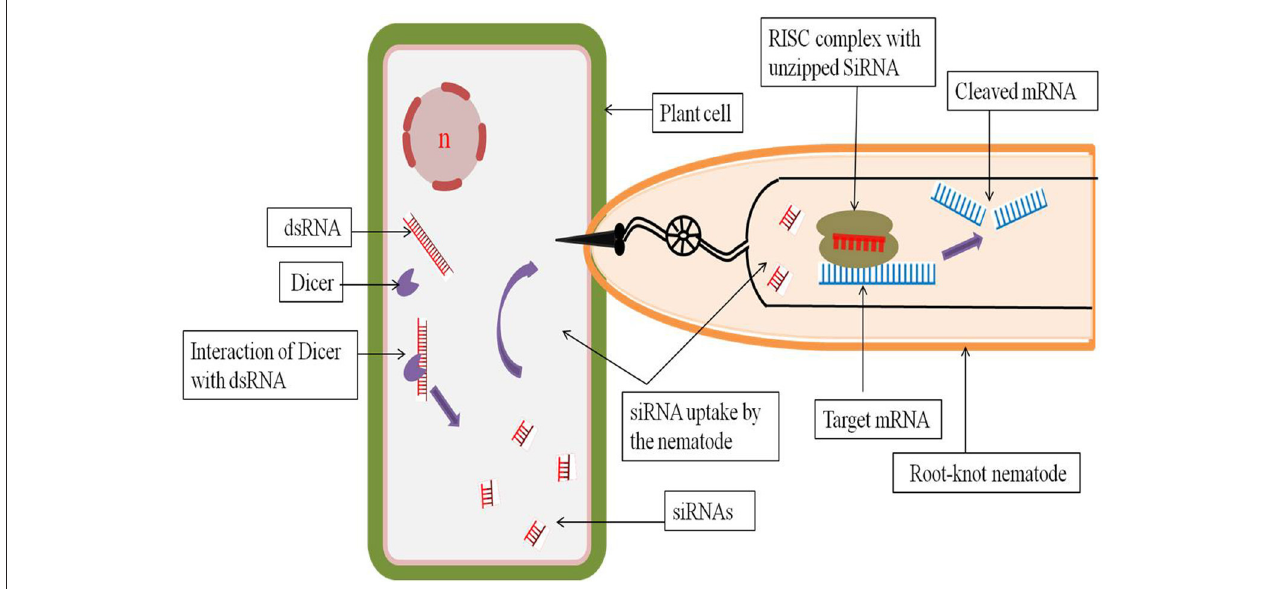
FIGURE 1 | Host generated RNAi through interaction between host plant cell and root-knot nematode. The dsRNA introduced into the host plant is recognized by the cellular RNAse III type enzyme dicer, which cuts the dsRNA into shorter fragments of 20–25 nucleotides called siRNAs. During infection into the host, the nematode ingests the siRNAs through its stylet. These host derived siRNAs are then processed by the nematode RNAi machinery where the unzipped siRNAs bound to the RISC complex cleaves the target mRNA in a sequence specific manner and inhibits further translation of the target mRNA.